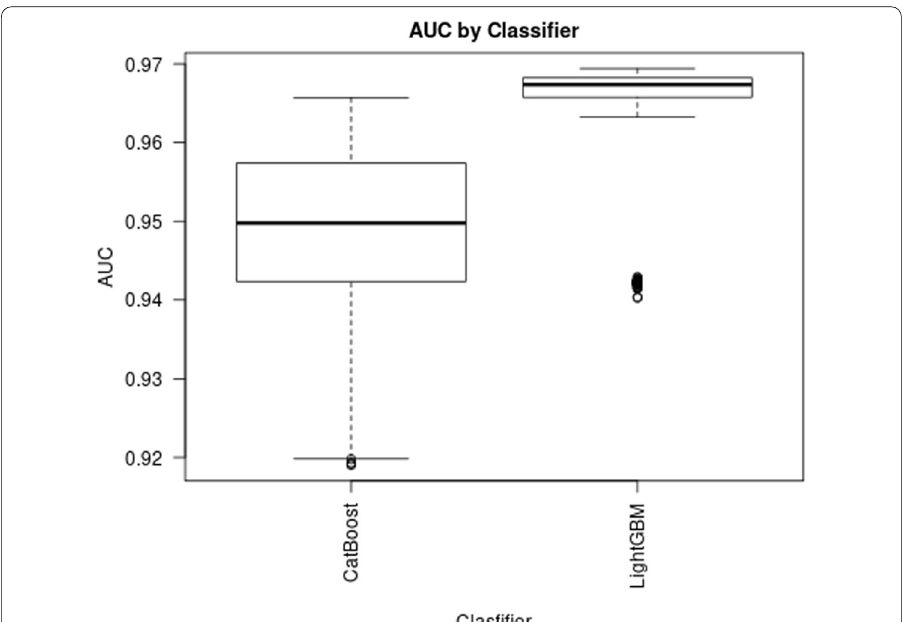
Fig. 5 Box plots of AUC values grouped by classifier; here datasets include destination port; Tukey’s HSD test indicates each factor (classifier) is in its own group